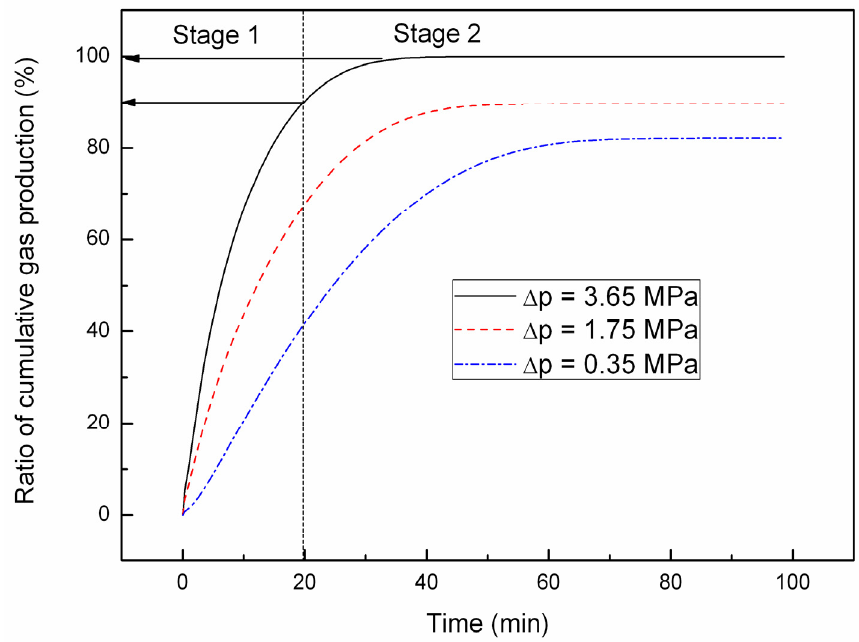
Figure 2. The percentage of cumulative gas production time evolution for different depressurizing